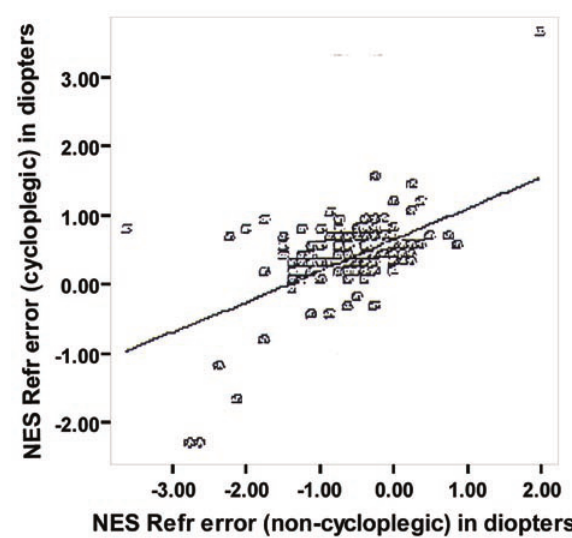
Figure 2: Comparison of nearest equivalent sphere of the refrac- tive error in children when measured under non-cycloplegic and cycloplegic